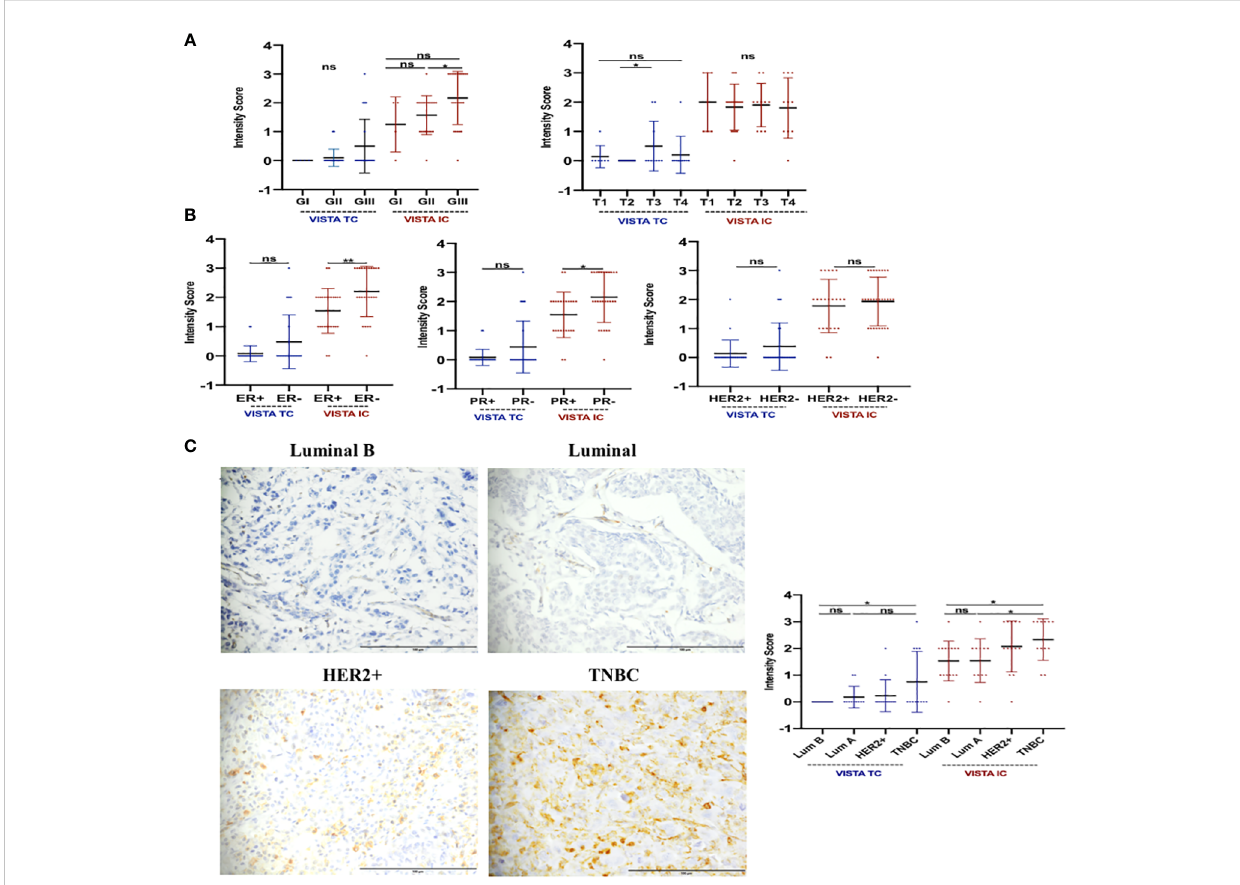
FIGURE 4 VISTA protein could be implicated in tumor progression of breast carcinoma. IHC assay was used to evaluate this expression. (A) Tumor grade and size might be regulated by VISTA expression. (B) VISTA upregulation in patients with ER, PR status, and breast cancer aggressive molecular subtypes (HER2+ and TNBC). (C) VISTA staining by Luminal B and A (magni fi cation ×40), HER2+ (magni fi cation ×40) and TNBC (magni fi cation ×40) molecular subtypes. Scale bare 100 µm. *Indicates p-value < 0.05, **Indicates p-value < 0.01. ns Indicates test non-signi fi